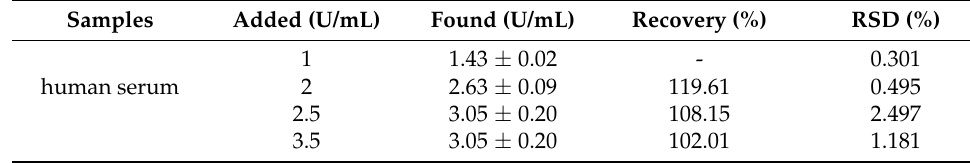
Table 2. Recovery analysis of ALP in human serum.